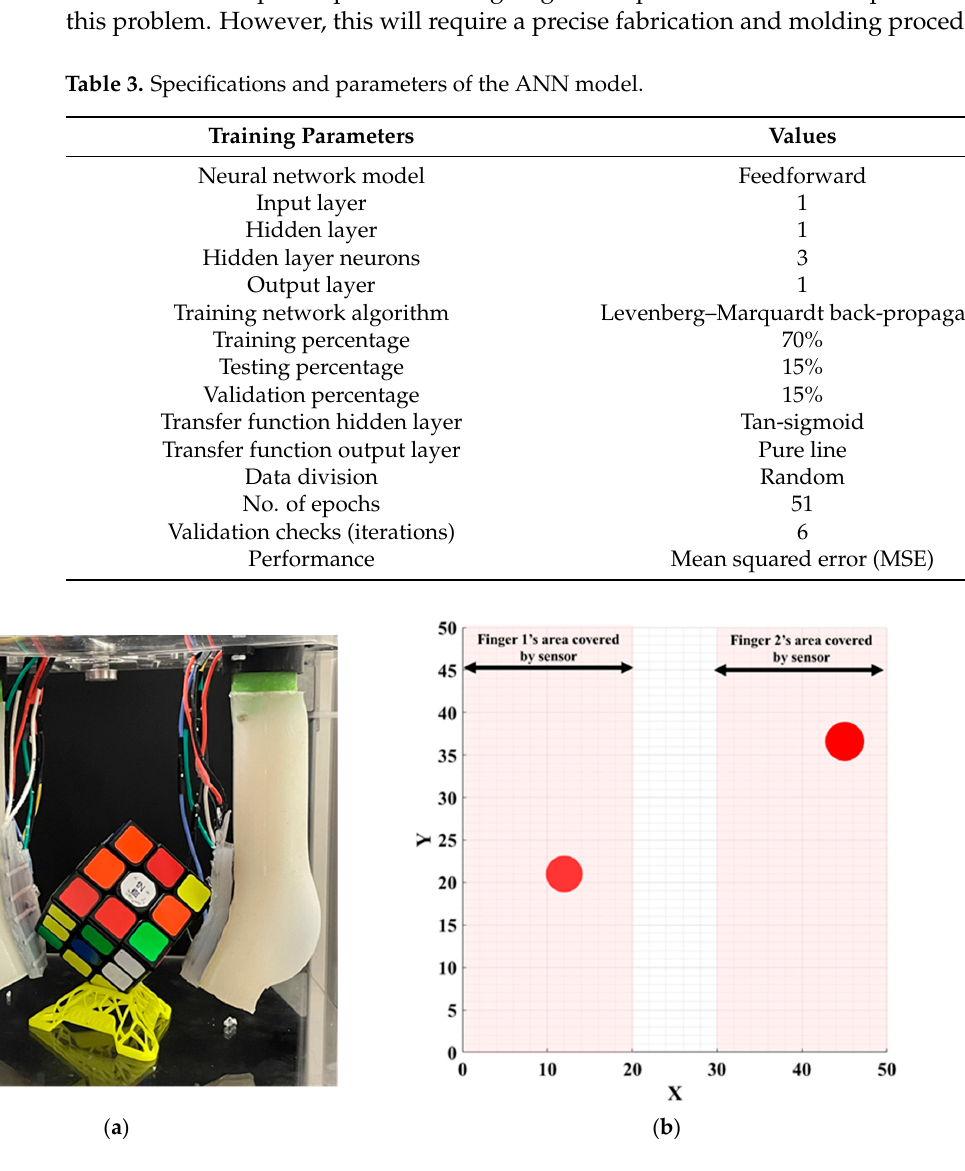
Figure 12. ( a ) Two calibrated capacitive/tactile sensors used for a soft robotic grasping application. ( b ) Both sensors can accurately measure the contact point and applied force (2.5